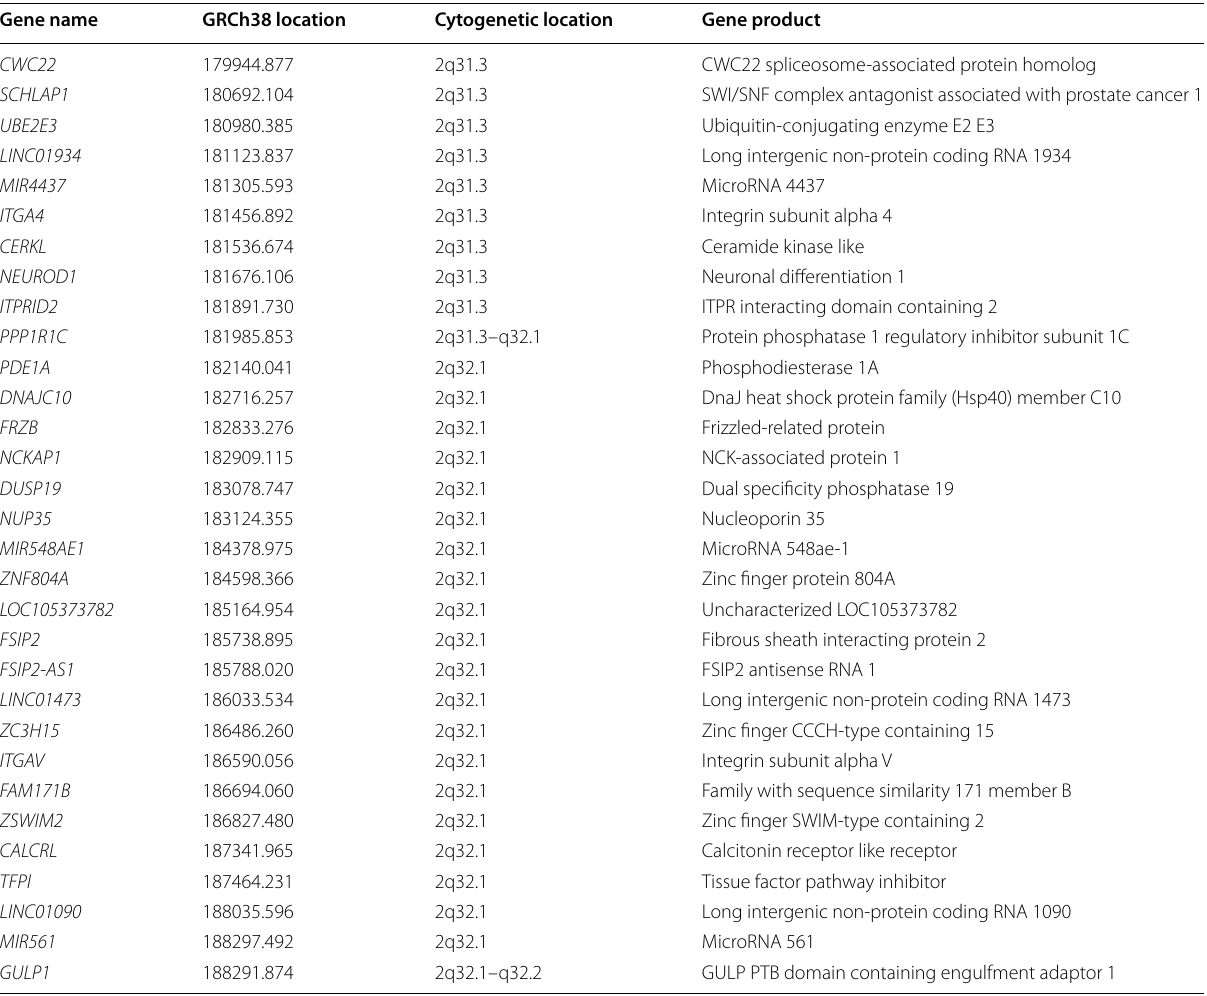
Table 5 List of the genes at 2q31.3–q32.1 on human chromosome 2